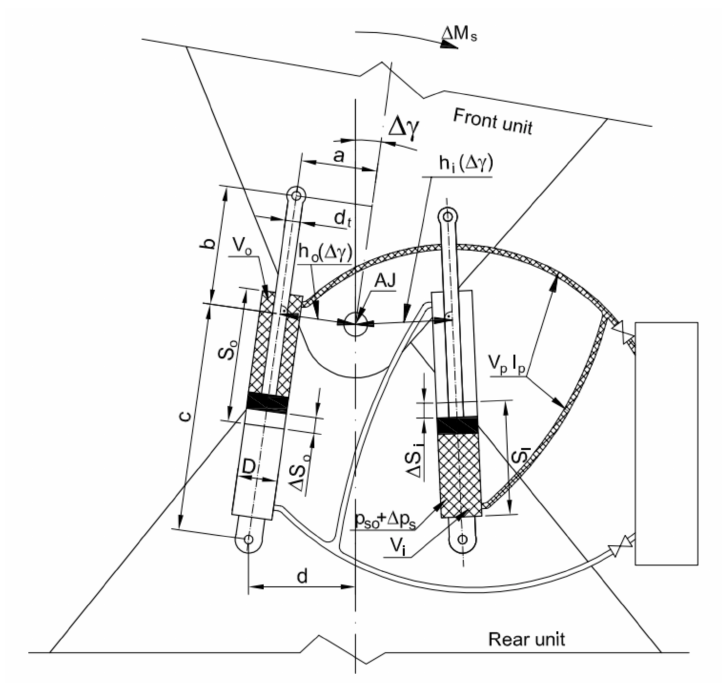
Figure 12. Schematic diagram of the AFSV units (frames) coupled using the hydraulic steering